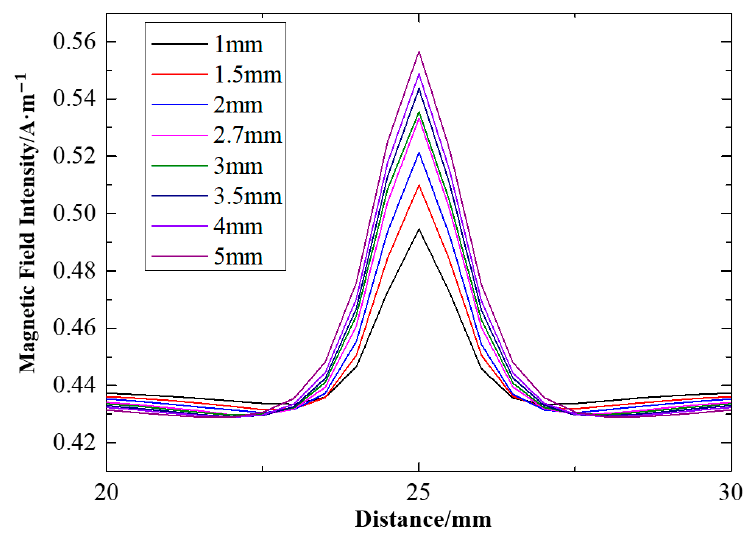
Figure 6. Magnetic fl ux leakage signals in Bx direction.